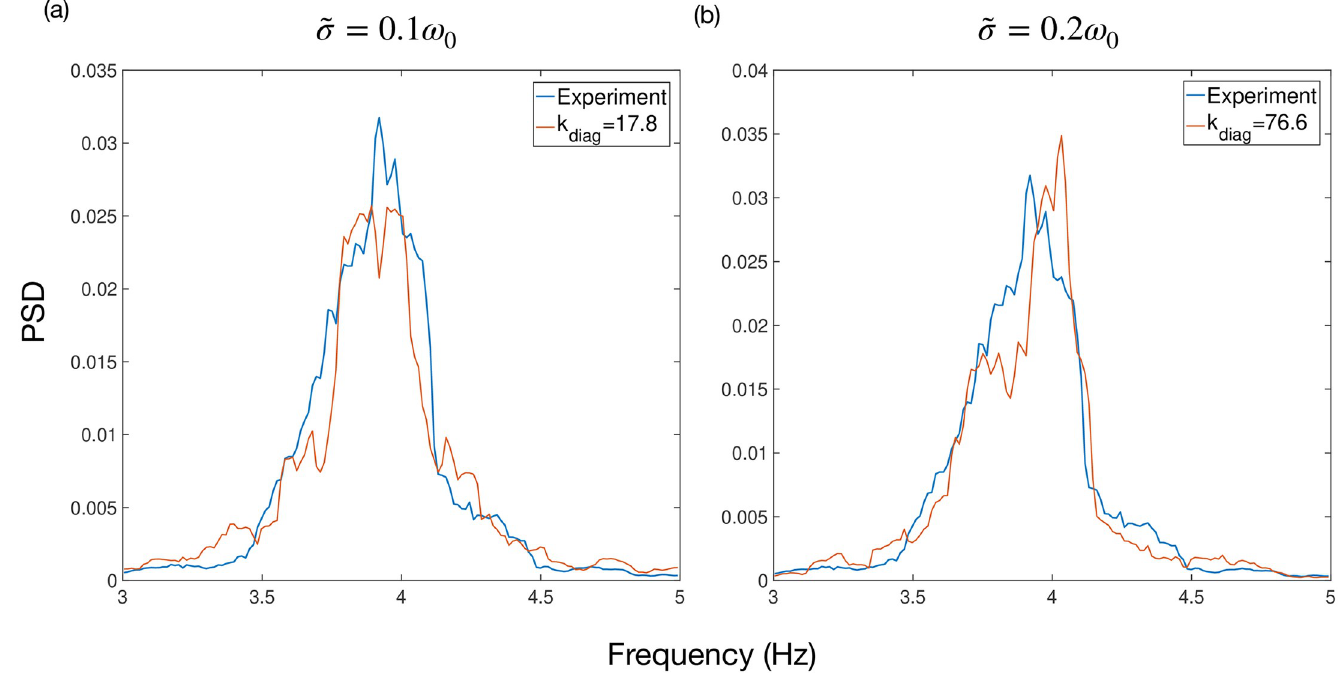
Fig 4. Power spectra of output from the multi population Kuramoto model for different values of ~ s . The parameters of the model (41) were chosen to reproduce tremor data from the study of Cagnan et al [17]. In each case, the value of k diag was chosen to give the best fit to the power spectrum of a single block from Patient 5’s